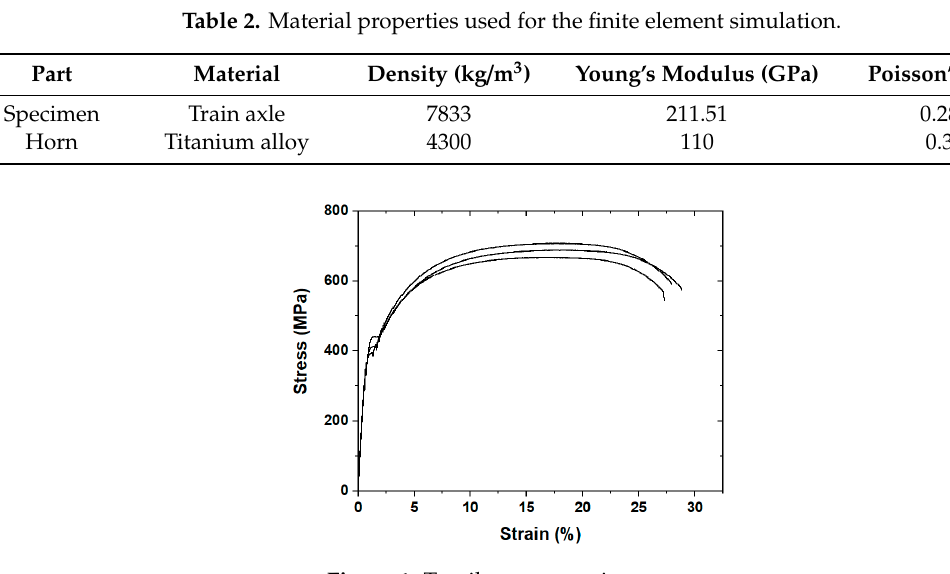
Figure 1. Tensile stress–strain